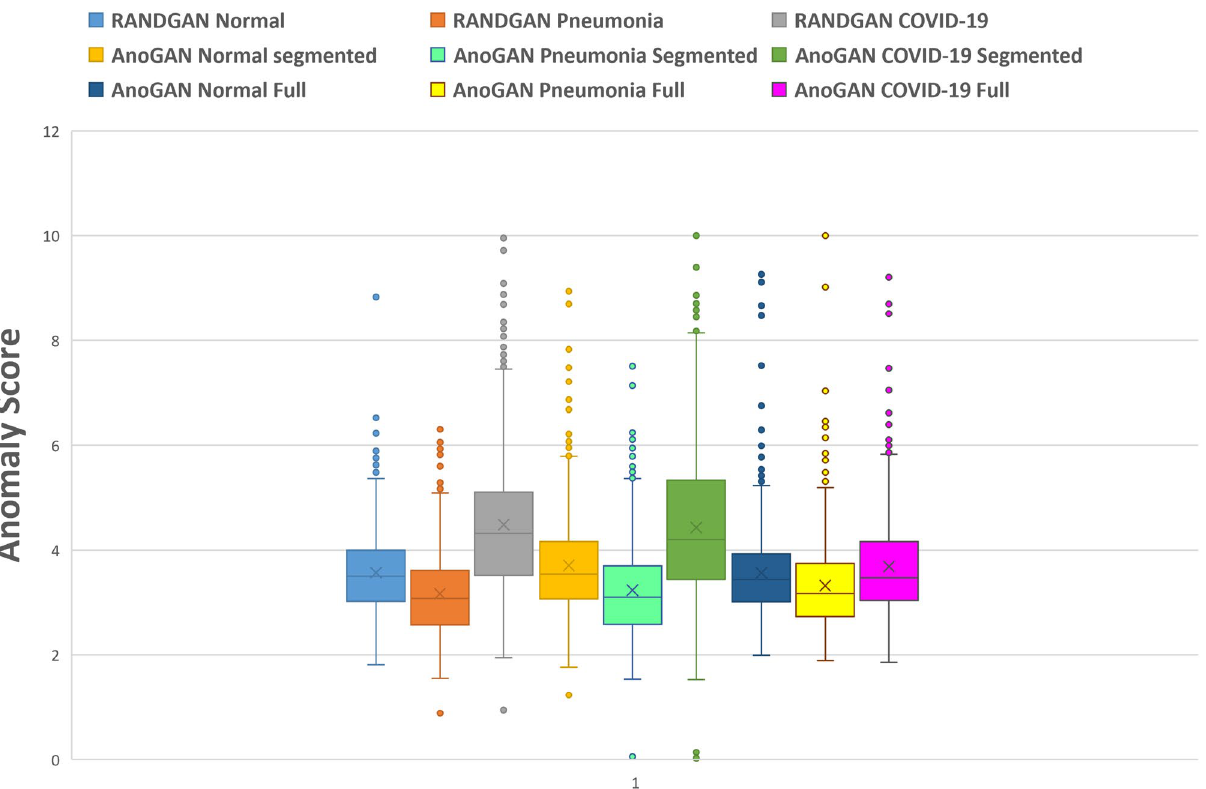
Figure 7. Normalized average anomaly score of the trained generative